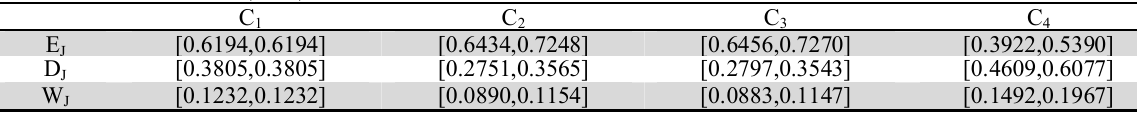
The calculation of E